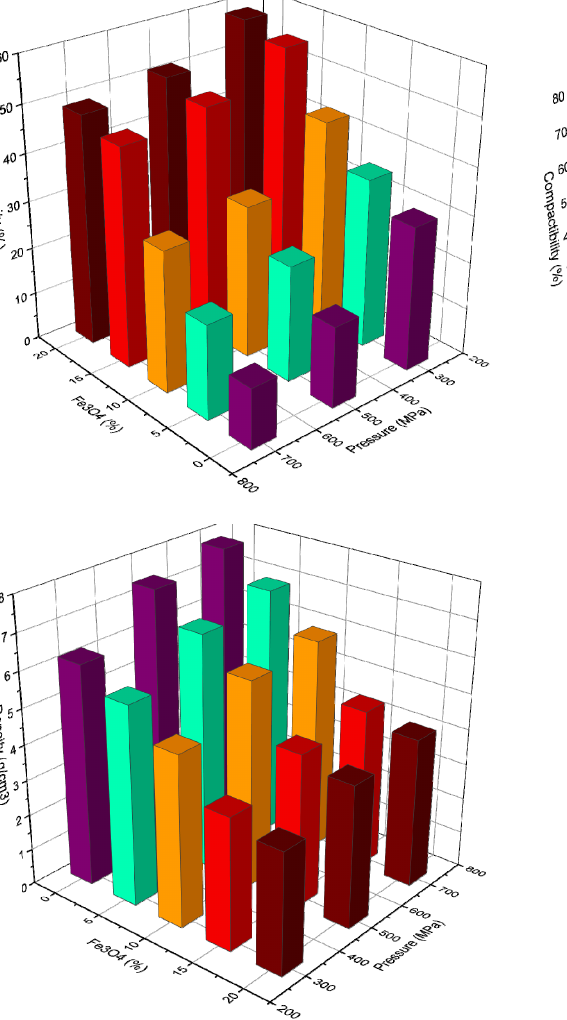
Figure 6. 3-D chart representation of the powder porosity, compressibility and density as a function of the Fe 3 O 4 amount and compacting pressure.